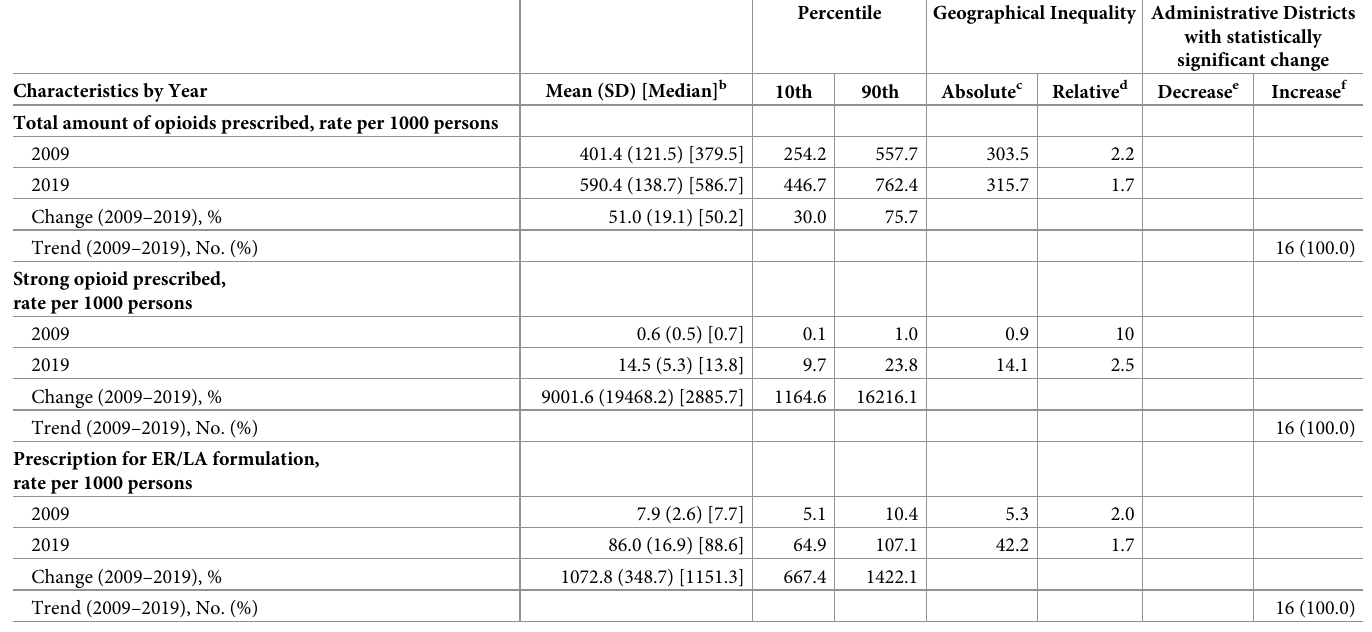
Table 2. Summary of trends in opioids prescribed for administrative districts in South Korea, 2009–2019 a